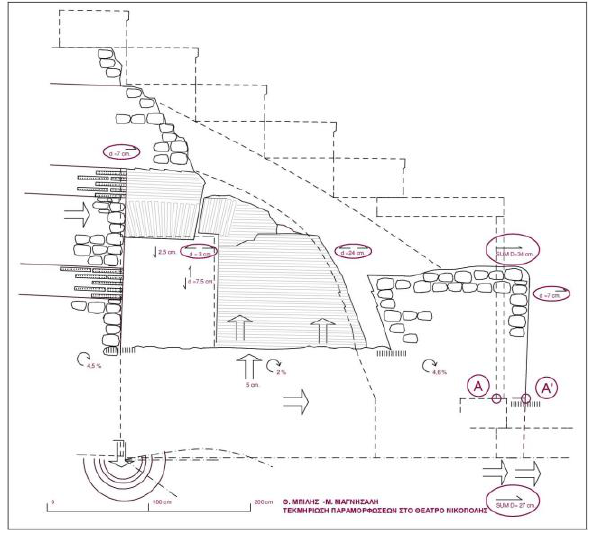
Figure 7. Section. Detail of